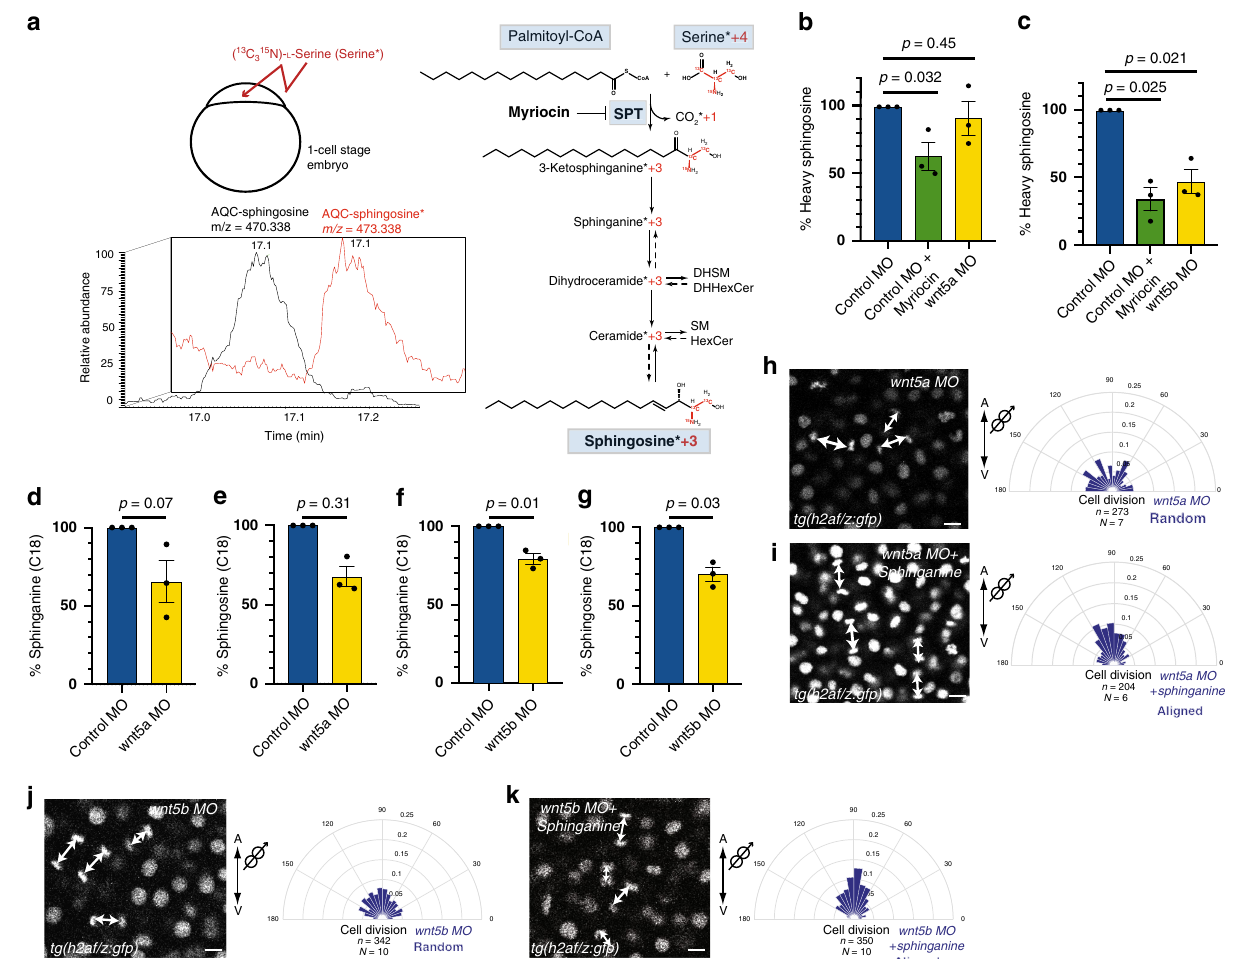
Fig. 2 Wnt5b signaling regulates the levels of sphingolipids by modulating SPT activity. a Scheme of metabolic tracer assay. One-cell stage embryos were injected with ( 13 C 3 15 N)- L -serine (heavy serine/serine*), which is incorporated into 3-ketosphinganine by SPT, losing one heavy carbon. Incorporation of the remaining three heavy carbons into the downstream sphingoid base sphingosine is used as a direct in vivo readout for SPT activity. Heavy sphingosine (red) co-elutes with sphingosine (black), but it can be distinguished due to its higher mass/charge ratio ( m / z ). These experiments were done three times independently for each condition. b , c Relative amounts of heavy sphingosine in wnt5a morphant embryos ( b ), wnt5b morphants ( c ) or embryos treated with Myriocin ( b , c ) from three independent experiments. d , e Relative amounts of C18 sphinganine ( d ) or C18 sphingosine ( e ) in wnt5a morphant embryos from three independent experiments. f , g Relative amounts of C18 sphinganine ( f ) or C18 sphingosine ( g ) in wnt5b morphant embryos from three independent experiments. Unpaired, two-tailed student ’ s t -test was used in ( b – g ). All error bars represent the standard error of the mean (SEM). h – k Orientation of division of epiblast cells with respect to the A/V embryonic axis determined by using H2A.F/Z:GFP transgenic line to monitor chromosome separation during anaphase. Left, representative confocal images of dorsal epiblast cells expressing H2A-GFP in wnt5a morphant s ( h ), in wnt5a morphants treated with sphinganine (0.5 nl of 10 μ M) ( i ), in wnt5b morphants ( j ) and in wnt5b morphants treated with sphinganine (0.5 nl of 25 μ M) ( k ). Division axes are marked by arrows. Animal pole is up. Scale bars: 10 µ m. Right, polar graphs showing the frequency distribution of the angle between the division axis and the A/V embryonic axis in wnt5a morphants ( h ) and in wnt5a morphants treated with sphinganine (0.5 nl of 10 μ M) ( i ), wnt5b morphants ( j ) and in wnt5b morphants treated with sphinganine (0.5 nl of 25 μ M) ( k ). n (number of cell divisions analyzed) over N (number of embryos). Note that rescue of randomization of division in wnt5b morphants requires higher amounts of sphinganine than for wnt5a morphants. In ( h – k ), χ 2 test